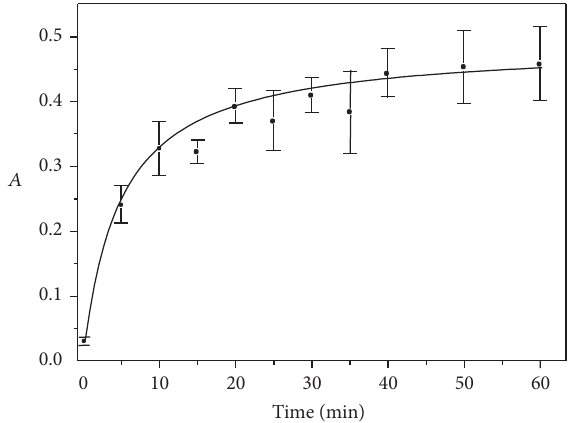
Figure 3: Concentration effect of KMnO 4 (5.0 × 10 −4 –1.0 × 10 −3 molL −1 ) on the AOF-KMnO 4 system, with AOF 2.2 × 10 −5 molL −1 , Na 2 SO 4 0.20 molL −1 , NaOH 0.30 molL −1 , T ∘ = 50 ∘ C, t = 30 min, and monitoring at 610 nm.